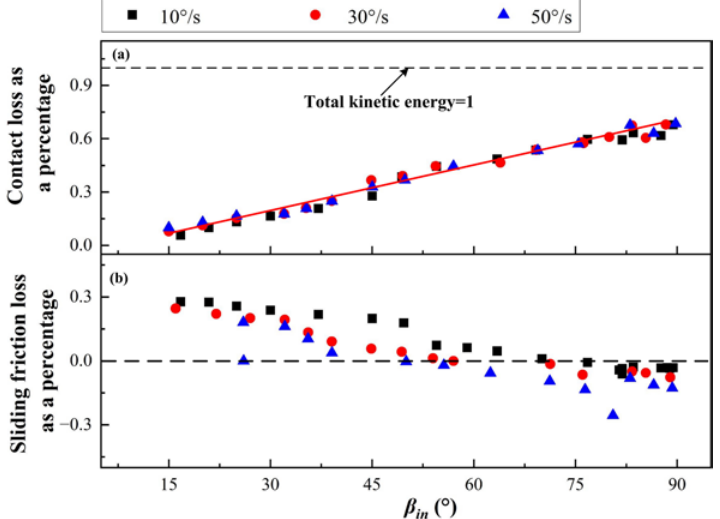
Figure 9. Ratio of particle kinetic energy loss to total kinetic energy at different rotational speeds: (a) Contact loss as a percentage; ( b ) Sliding friction loss as a percentage.